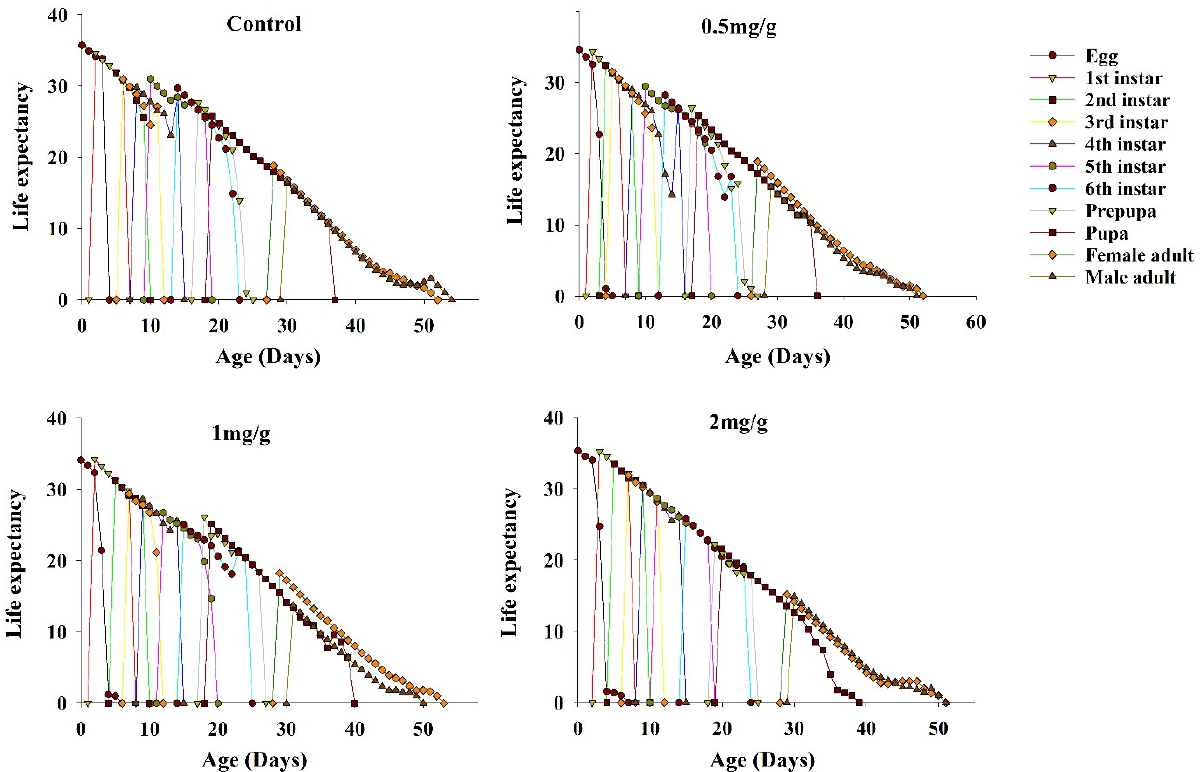
Figure 5. Age-stage specific life expectancy ( e xj ) of Spodoptera frugiperda at different GO concentrations.